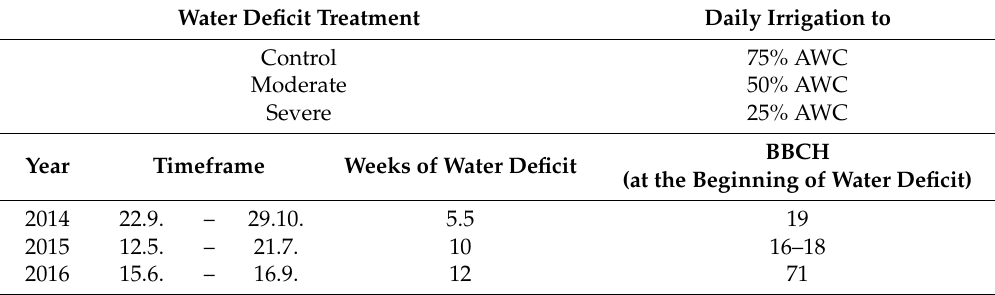
Table 1. Characterization of water deficit treatments and experimental information from 2014 to 2016. Water Deficit Treatment Daily Irrigation to Control 75% AWC Moderate 50% AWC Severe 25% AWC Timeframe Weeks of Water Deficit